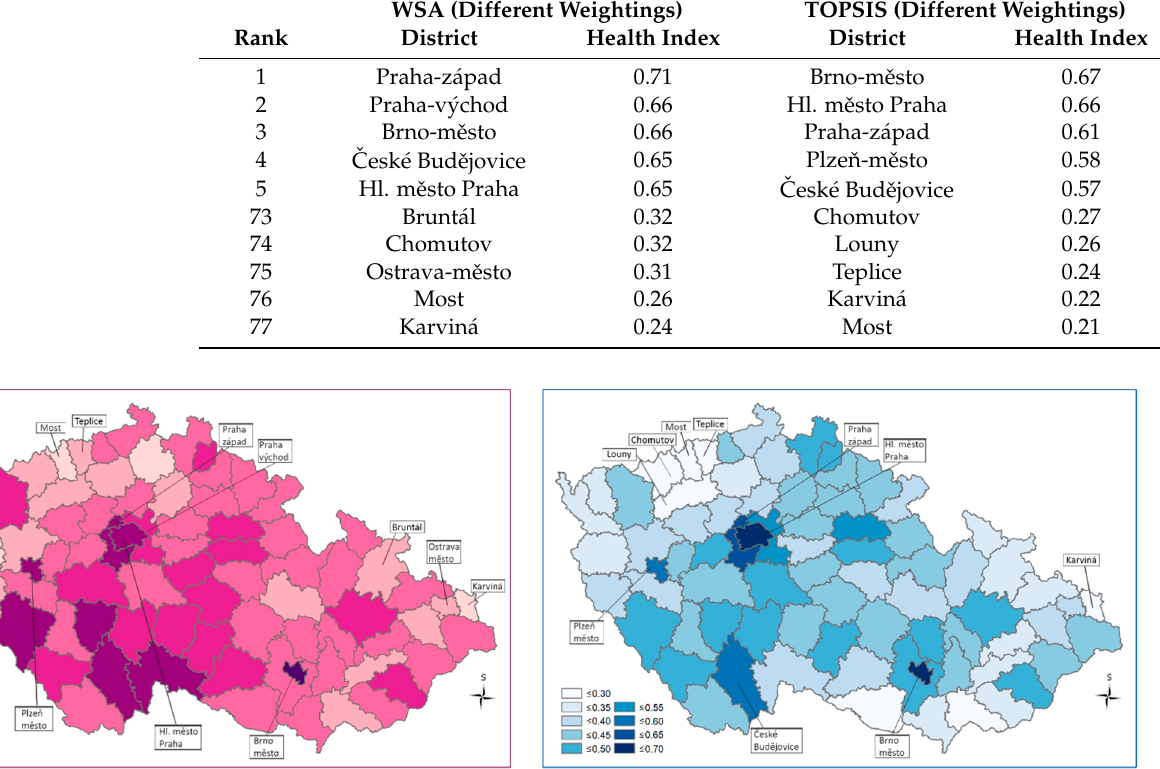
Figure 2. Spatial differentiation based on the calculation of the Health Index values using different weightings—WSA method, left side map, TOPSIS right side map 1 . 1 The higher Health Index values are indicated by the darker color of the districts, suggesting a more favorable situation. Table 3. Health index, WSA, and TOPSIS method, different weightings of areas (selection of the best and worst five dis- tricts of the Czech Republic).